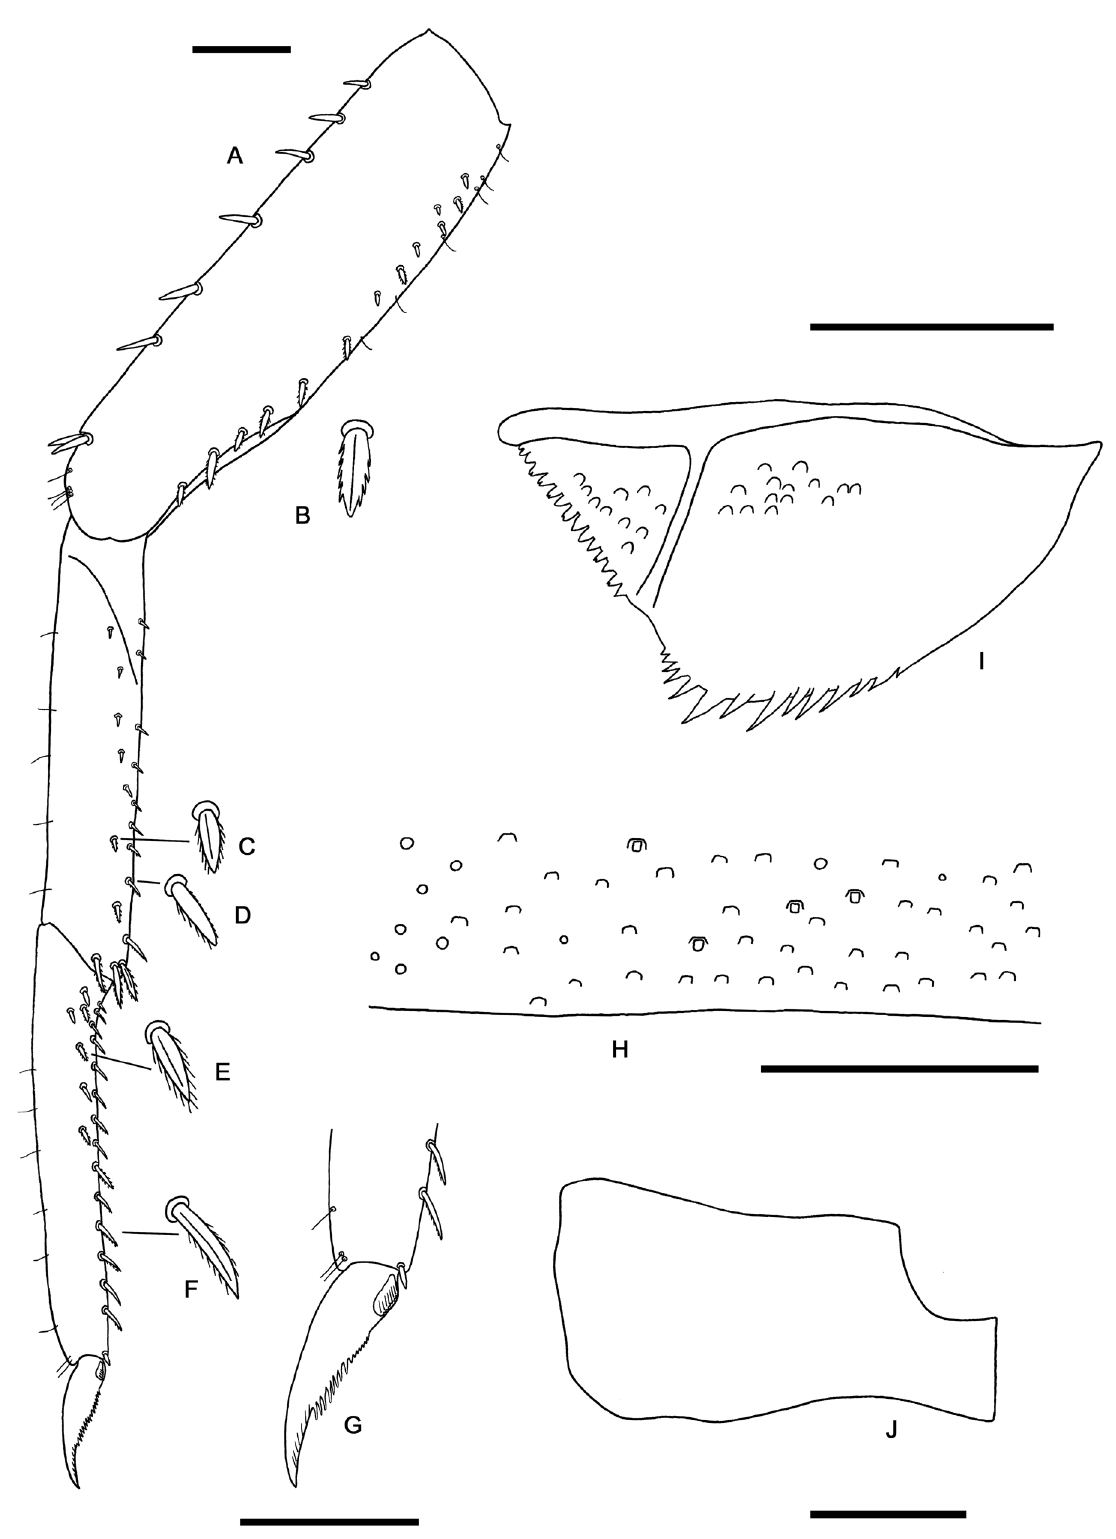
Fig. 9. Procerobaetis freitagi gen. et sp. nov., larval morphology. A . Foreleg. B . Seta on ventral margin of femur. C . Seta on ventral surface of tibia. D . Seta on ventral margin of tibia. E . Seta on ventral surface of tarsus. F . Seta on ventral margin of tarsus. G . Fore claw. H . Tergum IV. I . Paraproct. J . Metanotum. Scale bars: 0.1